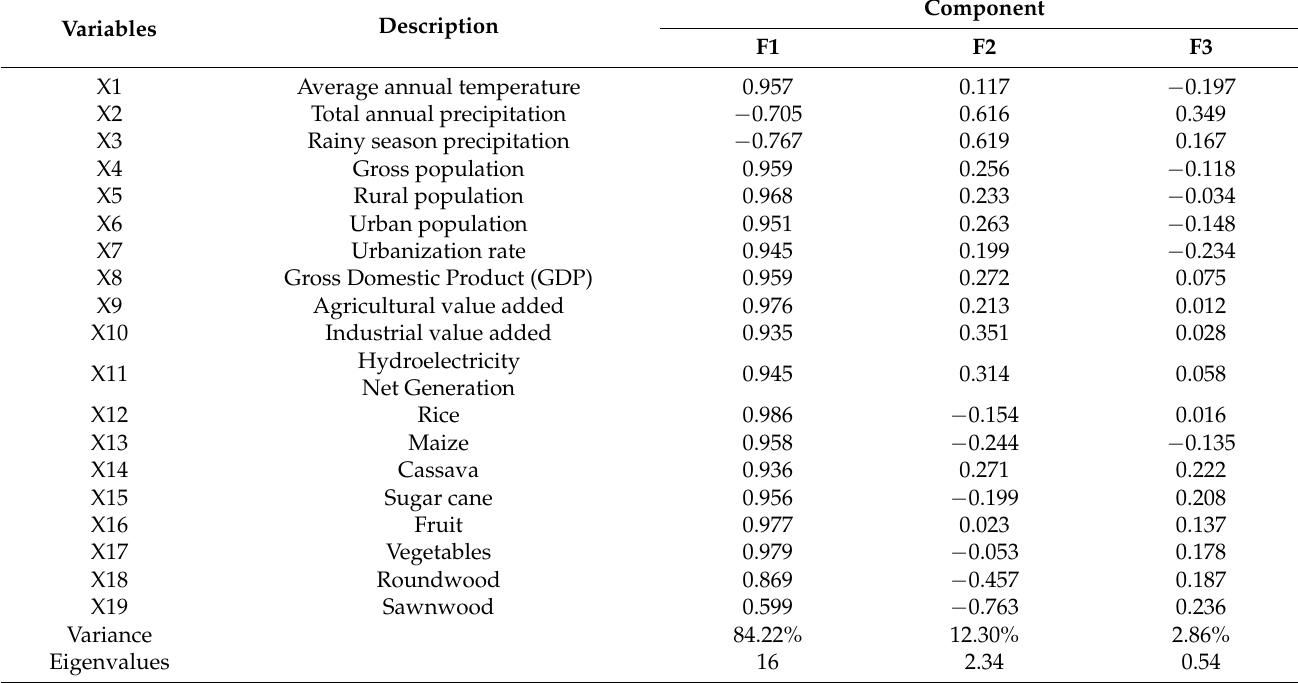
Table 3. Rotated component matrix of the principal component analysis.